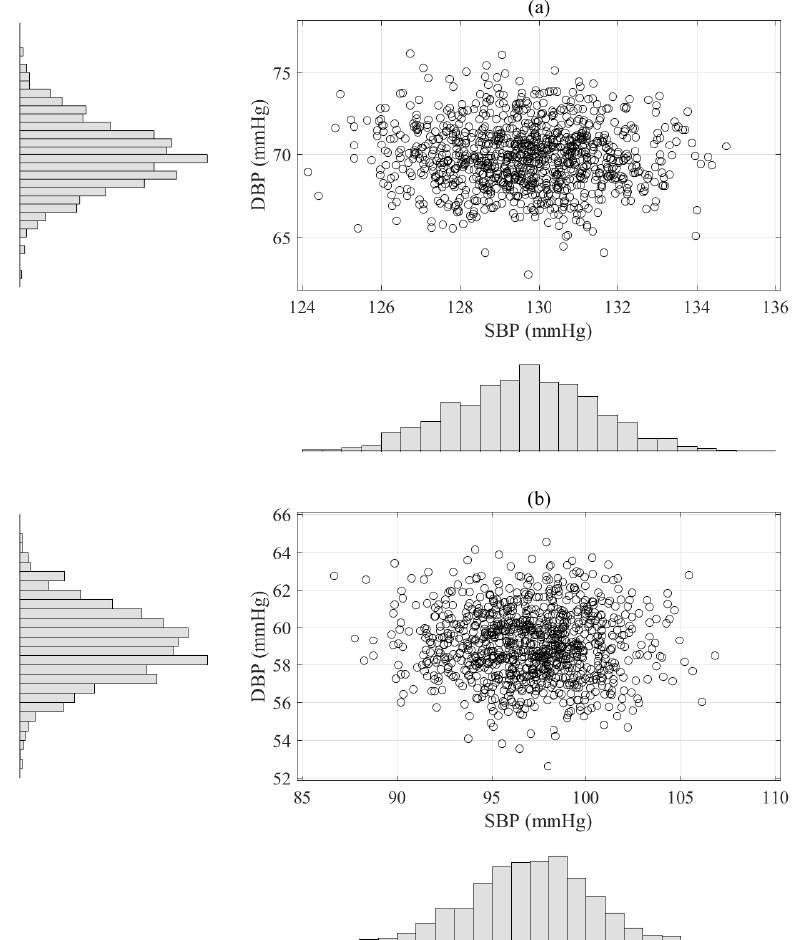
Figure 3. Scatter histograms of BP estimation based on the parametric bootstrap approach with replication numbers ( N = 1000) using the results of the deep learning estimator, where the upper plot ( a ) is an example obtained from one subject and the bottom plot ( b ) is another example acquired from different